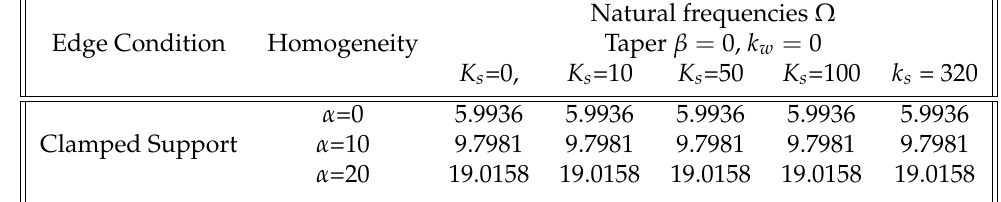
Table 7. Influence of homogeneity on fundamental natural frequency of shear Pasternak